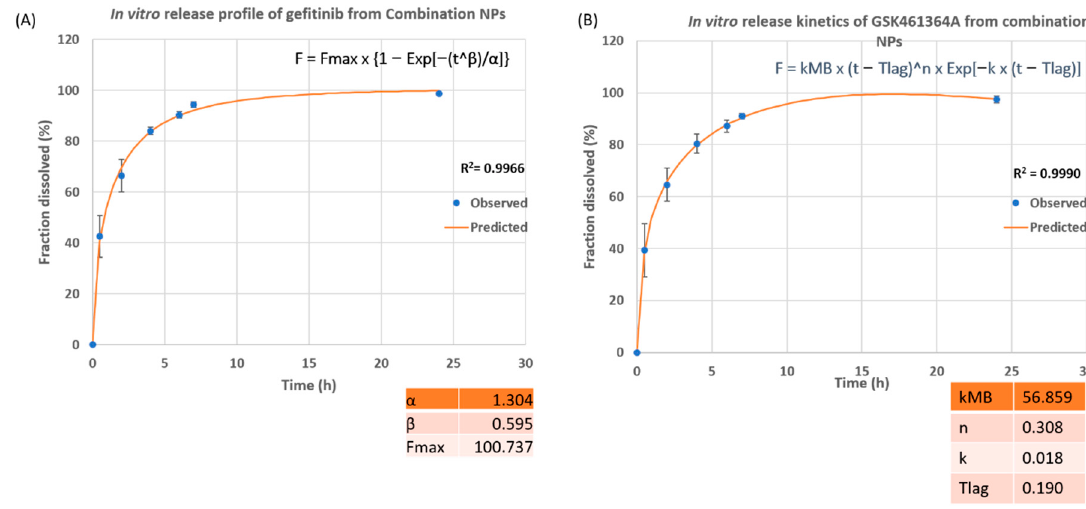
Figure 7. In vitro release profile of ( A ) gefitinib and ( B ) GSK461364A from dual drug loaded PLGA- PEG nanoparticles (combo NPs) at 37 °C, 1X PBS, pH